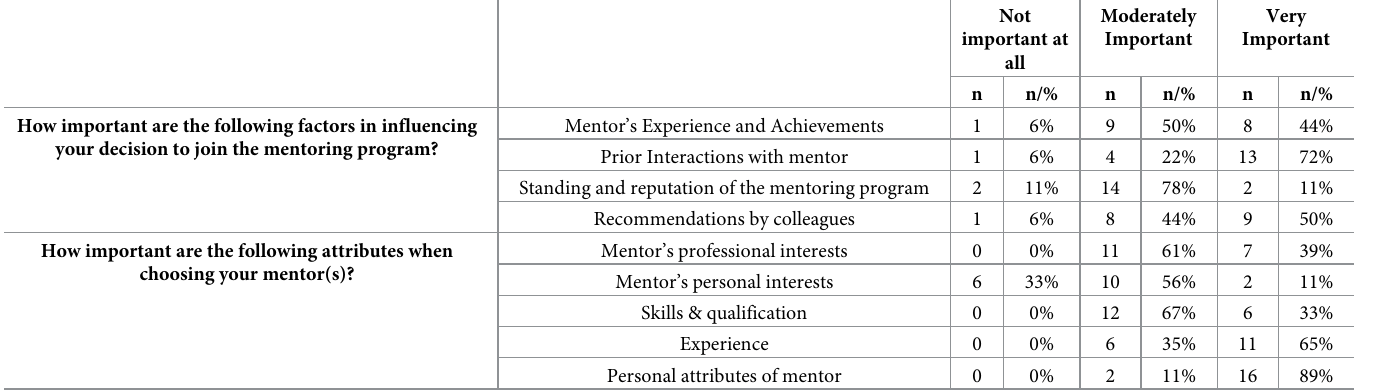
Table 3. Factors influencing participation in PMI and mentor